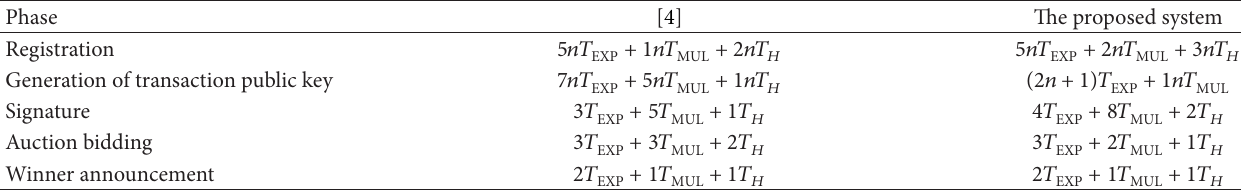
Table 3: Analysis of computation